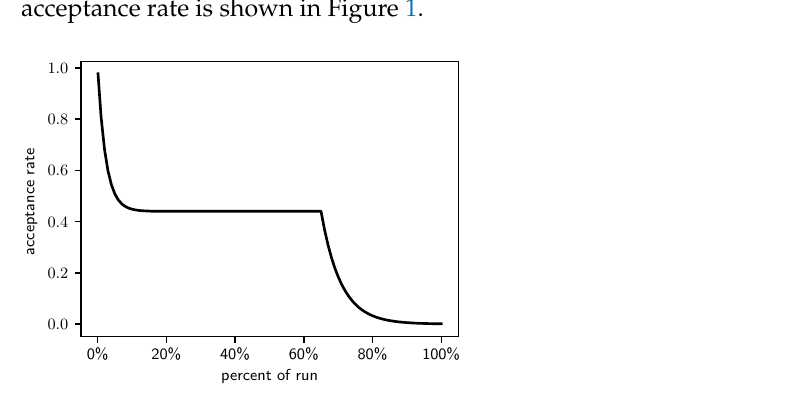
Figure 1. The Lam target acceptance